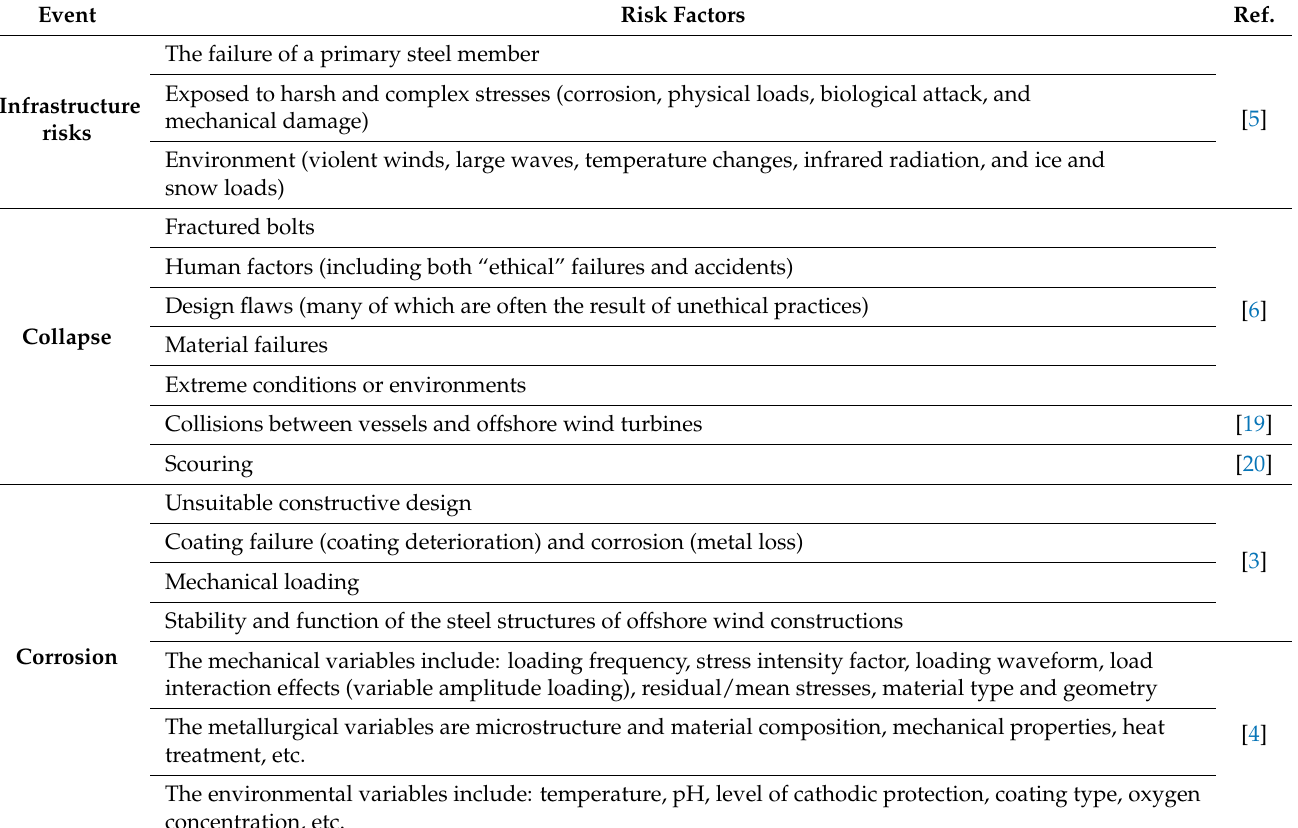
Table A1. An overview of accidents and risk factors in related research. Risk Factors